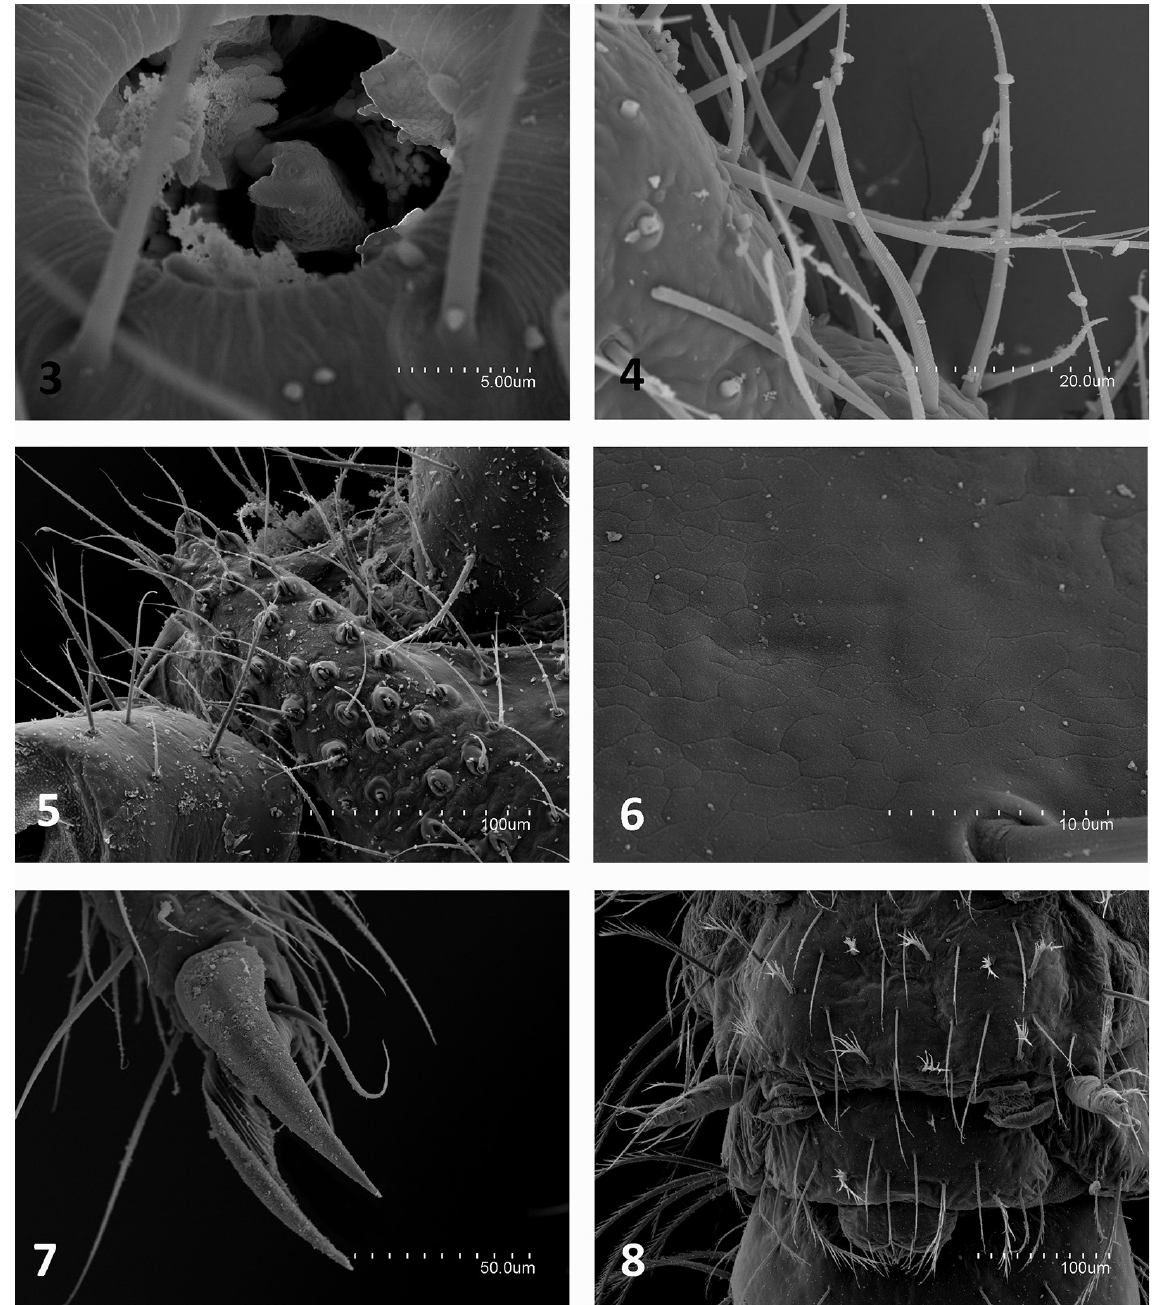
Figs 3–8. Plusiocampa ( Dydimocampa ) evallonychia Silvestri, 1949, from Mamut-Tshokrak Cave, Baidarsko-Balaklavsky karst massif, Crimean Peninsula (Coll. AS). 3 . Cupuliform organ. 4 . Lateral side of a middle antennomere with several gouge sensilla. 5 . Frontal process. 6 . Surface of